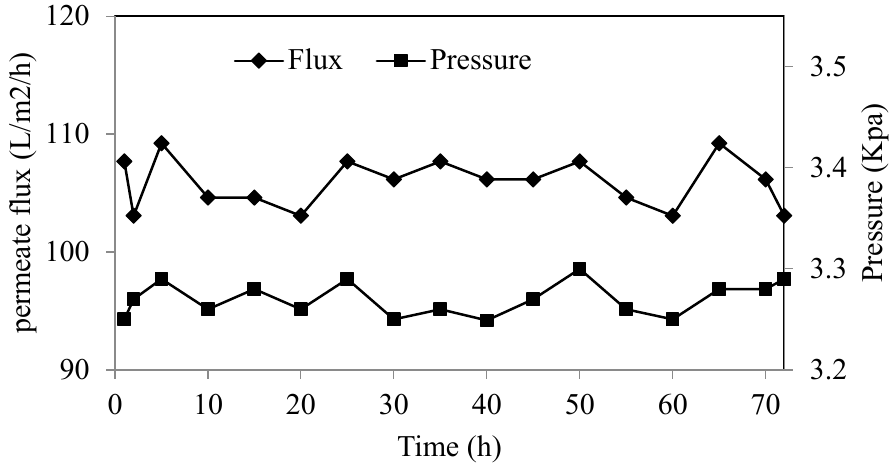
Figure 2. Permeate flux and pressure data during ceramic filtration experiments.